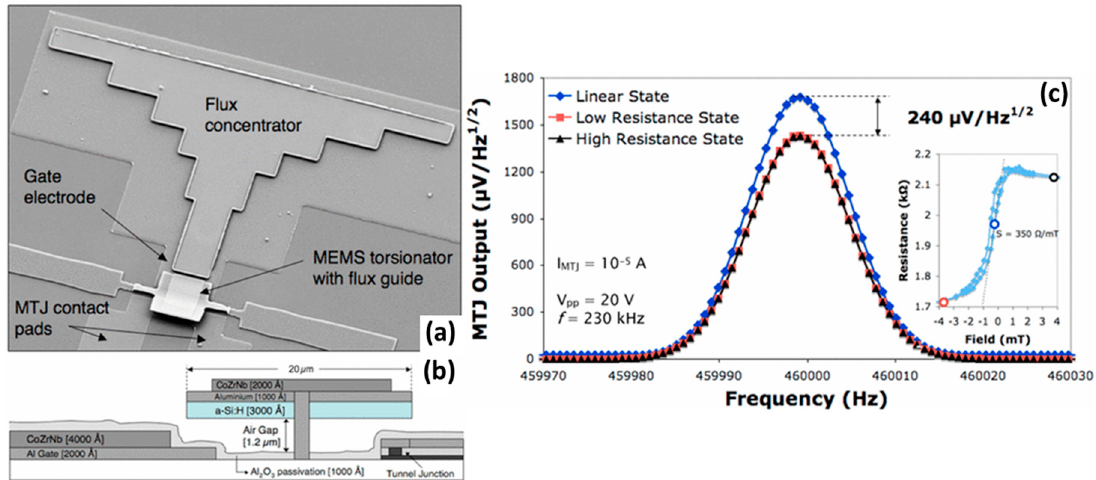
Figure 8. ( a ) SEM image of the device exhibiting the MEMS torsional structure integrated with a MTJ sensor and both static/dynamic MFCs; ( b ) Schematic view of the device cross section; ( c ) MTJ voltage output corresponding to the detection of a DC magnetic field of 0.36 mT when the torsional structure is actuated at a frequency of 230 kHz. Both magnetic and electric (capacitive coupling) components are presented. Reproduced with permission from Guedes A. et al. , IEEE Trans. Magn. 2008, 44 , 2554; published by IEEE, 2008.